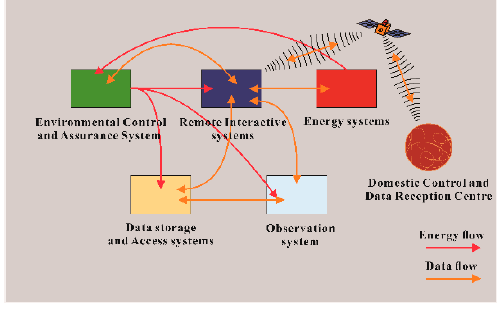
Figure 1. Block diagram of the entire system.